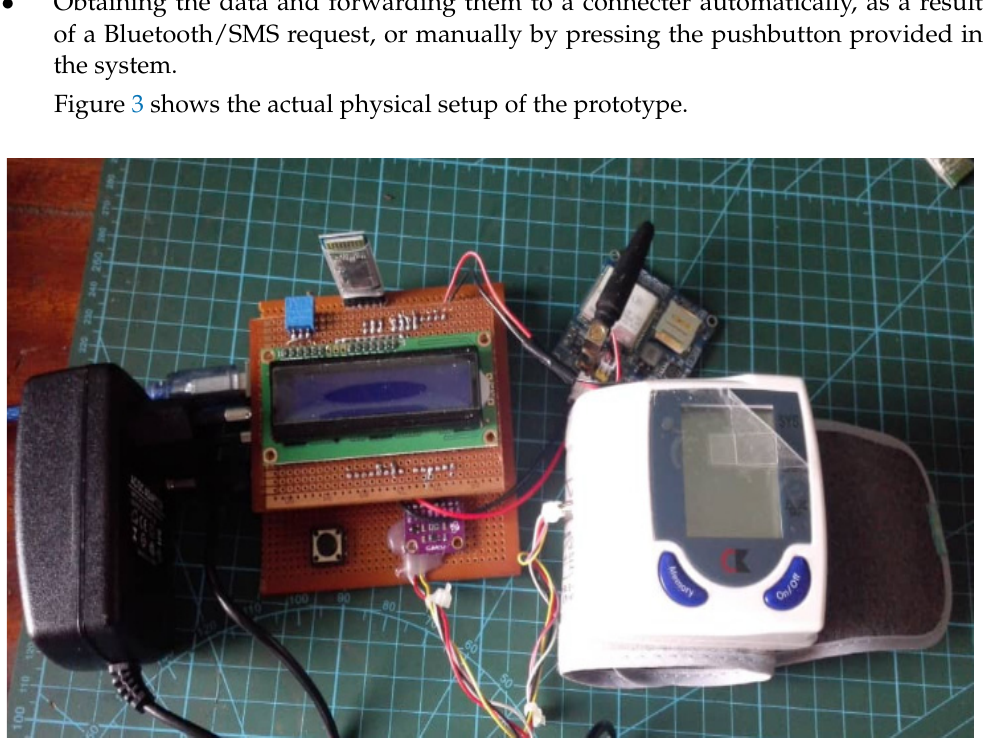
Figure 3. Prototype of various components connected with the RPM microcontroller.